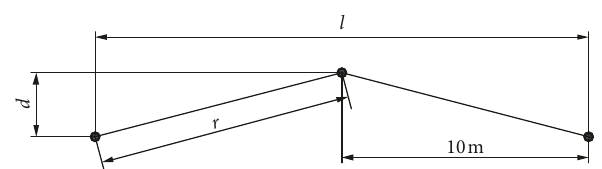
Figure 9: Fractal graphics of “triangular-fractal” blasting